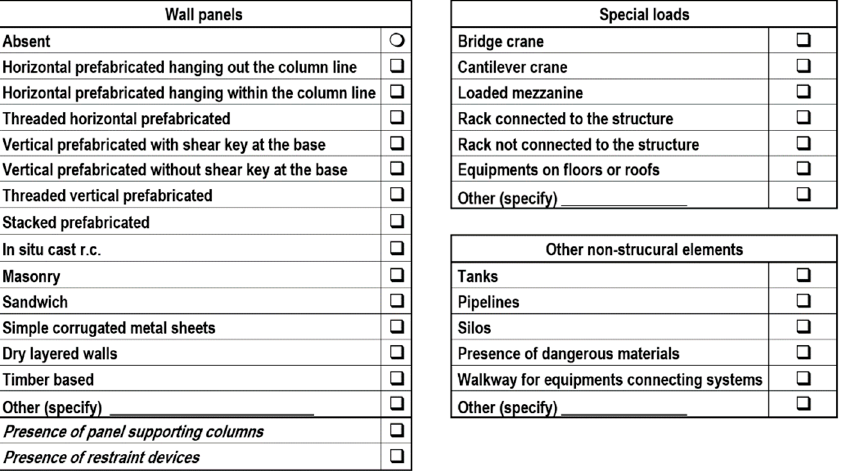
Figure 21. Section 2C CARTIS-Building: Typology of connections, panels, special loads, other non-structural elements (English version [19]).